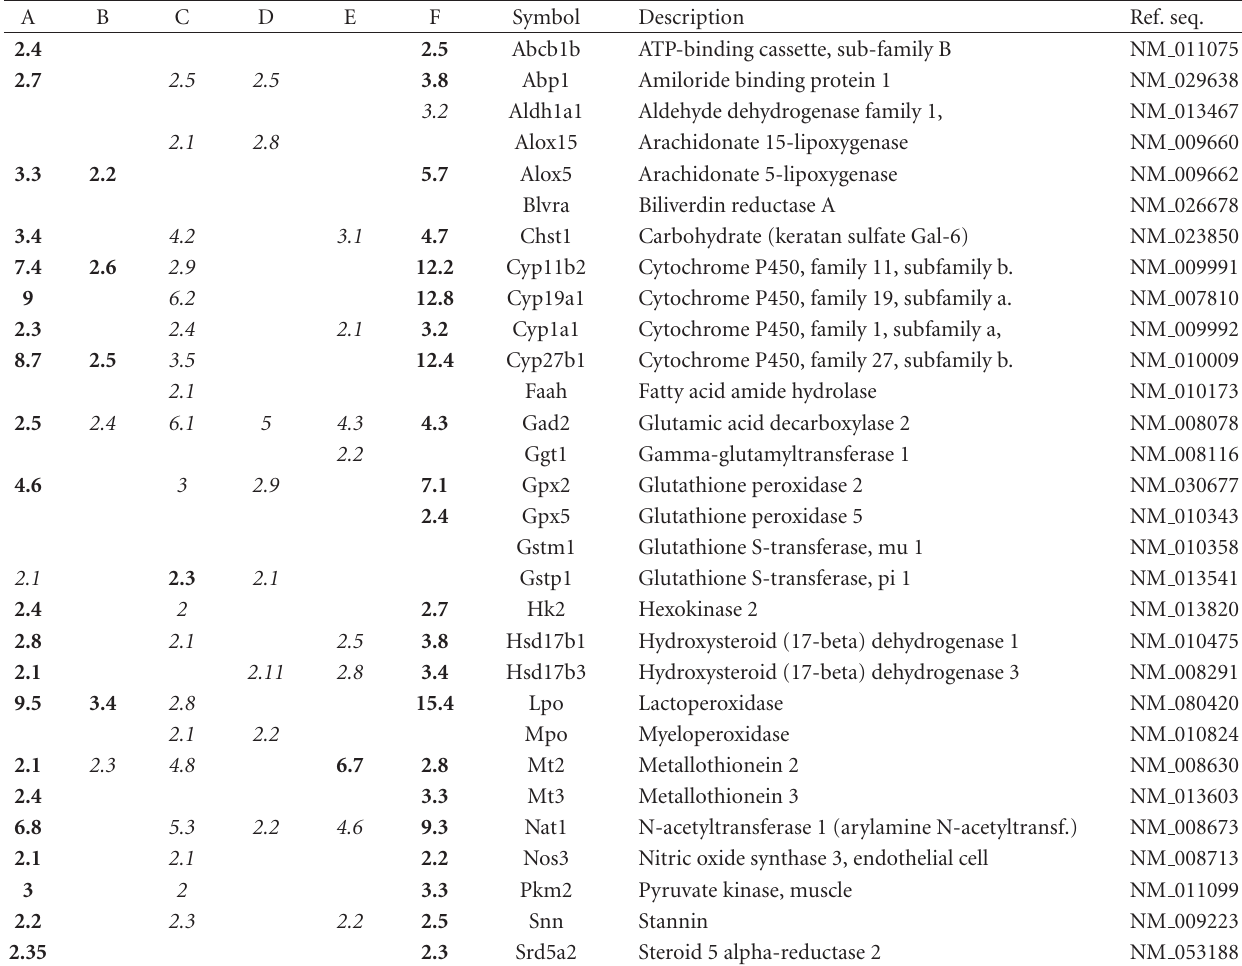
Table 3: A list of genes regulated more than 2 times up (bold) or down (italic). Regulation caused by: A Tween 1%, B equol, D HIM, E LIM, and F 17- β estradiol compared to control (mice feed water) and C equol compared to